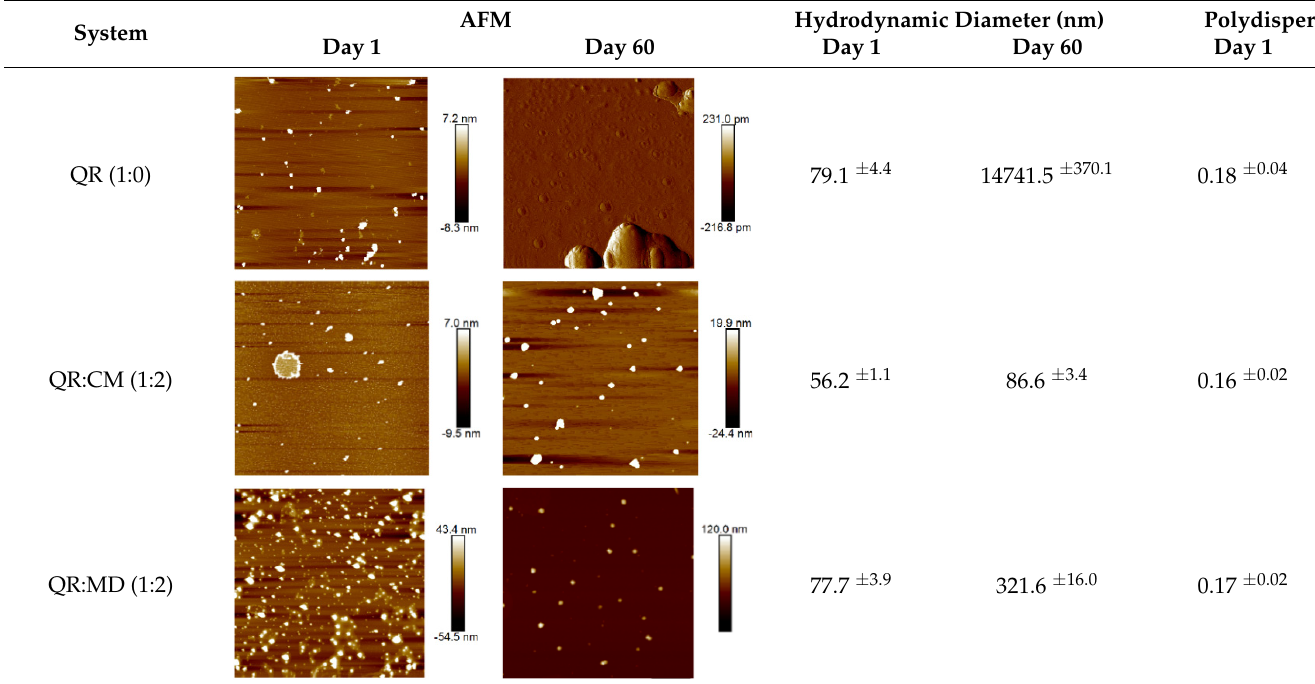
Table 3. AFM images, hydrodynamic diameter, PdI, and Z potential for the best AgNPs systems at different times.